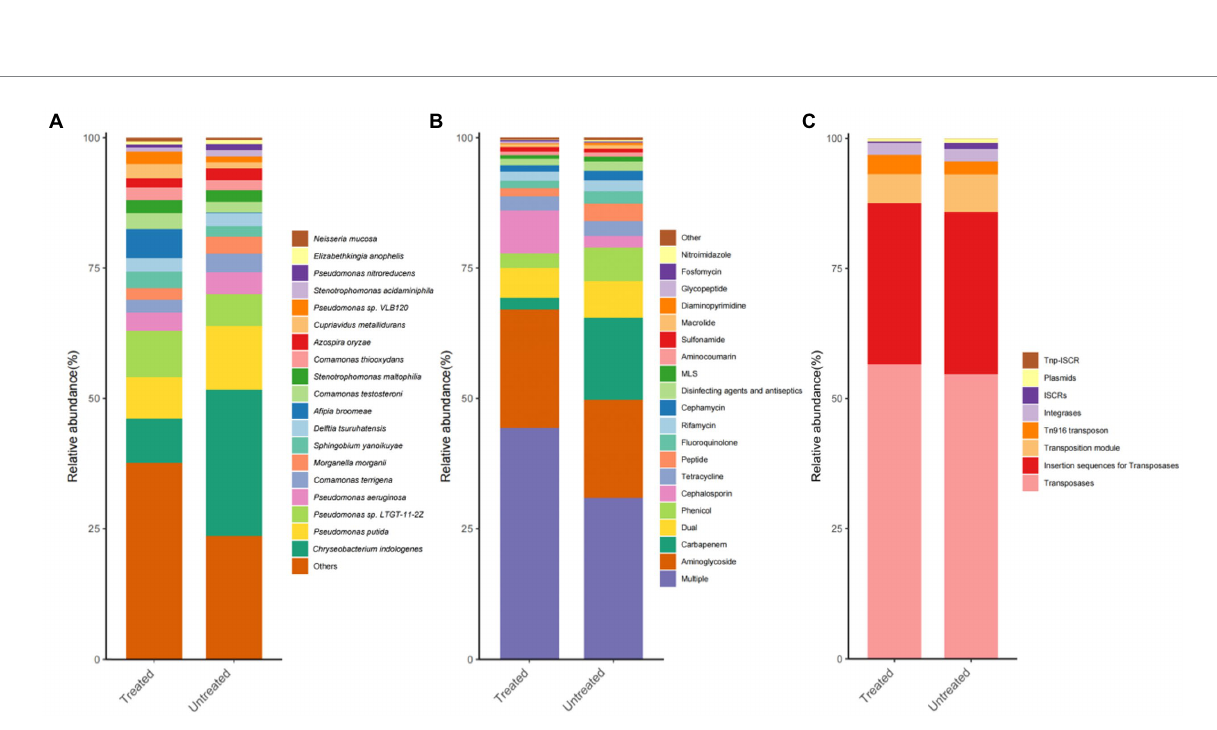
FIGURE 2 Histograms of the relative abundance distributions of the TOP 20 dominant species, ARGs and MGEs in dental waste waters. The abscissa represents the sample groups, and the ordinate corresponds to the proportion of dominant species. (A) Bacteria; (B) ARGs; and (C) MGEs. The color order from top to bottom of the histogram corresponds to the color order of the legend on the